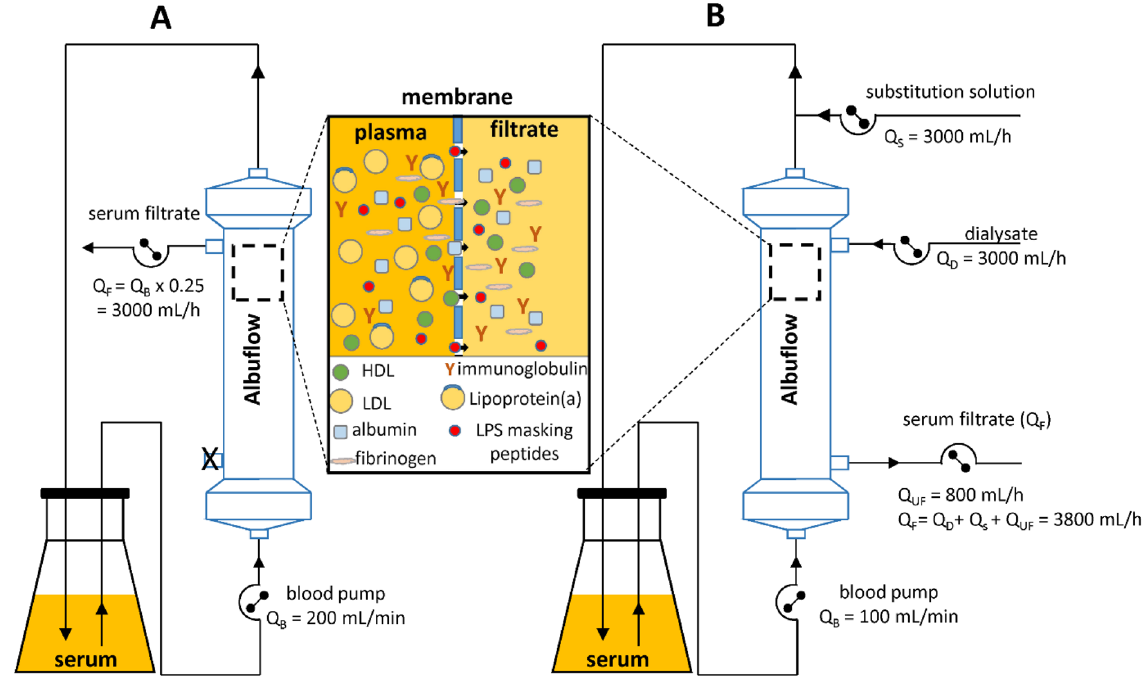
Figure 18. Schematic representation of the production of lipoprotein-enriched and lipoprotein-depleted serum. ( A ) Lipoprotein-depleted serum was obtained by filtration of serum through the Albuflow plasma filter, which has a molecular cut off of 250 kDa. ( B ) Lipoprotein-enriched serum was produced by haemodiafiltration with postdilution and ultrafiltraion. Q F flow rate of serum filtrate, Q B flow rate of the blood pump, Q S flow rate of substitution solution (postdilution), Q UF flow rate ultrafiltration, Q D flow rate of